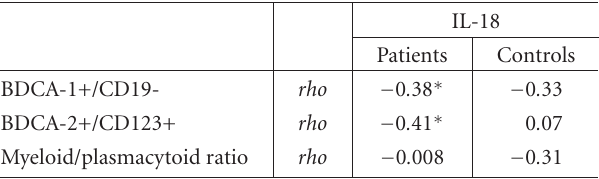
Table 2: Spearman rho correlation coe ffi cients between IL-18 and DCs in patients with psoriasis and healthy controls. Correlations marked by asterisk are statistically significant with P < . 05.